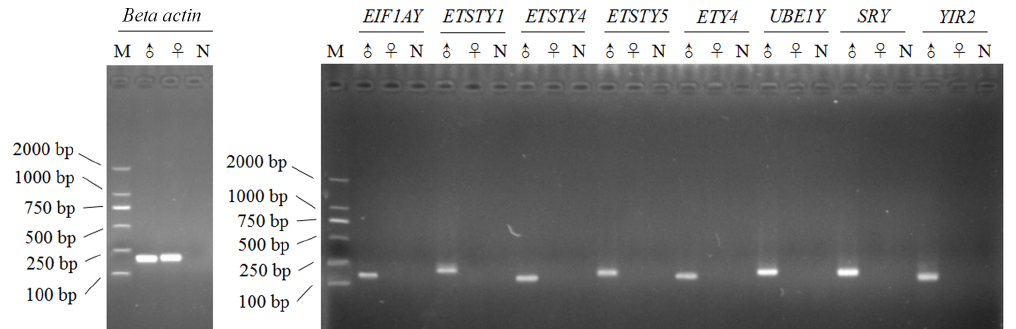
Figure 1. Gel electrophoresis of the PCR products of the beta actin gene and the eight Y chromosome horse genes. M is the 2kb DNA ladder; ♂ is male horse genomic DNA; ♀ is female horse genomic DNA; and N is the negative control (distilled